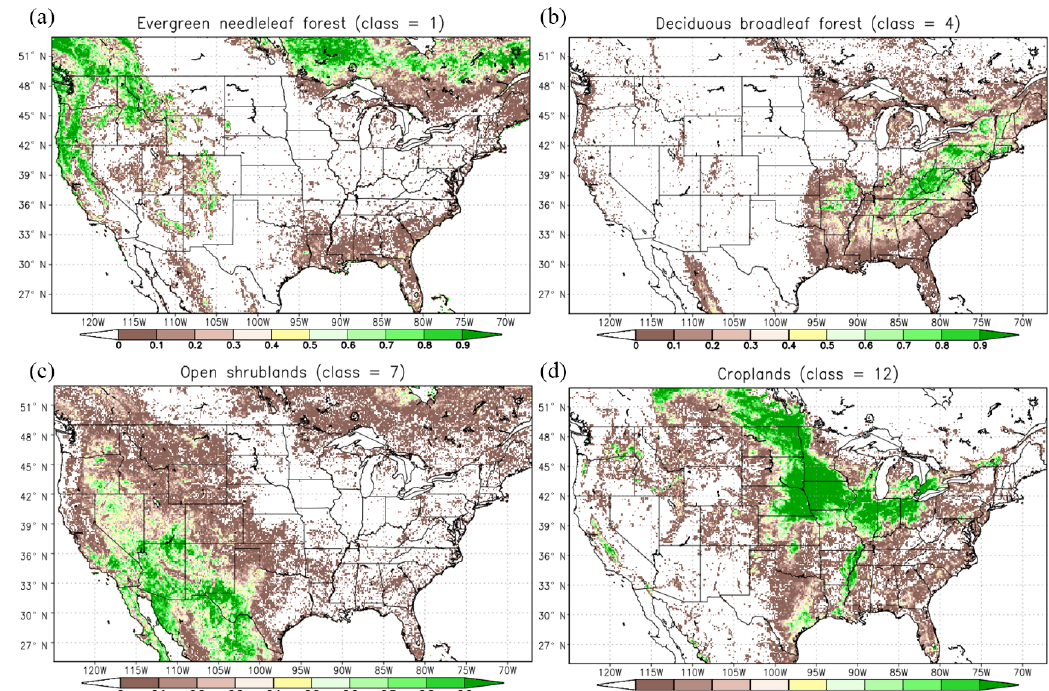
Figure 4. Vegetation distribution fraction of four different MODIS IGBP land cover classes (as produced by LDT): evergreen needleleaf (a) , deciduous broadleaf forest (b) , open shrublands (c) , and general cropland (d) . Values greater than 0.9 indicate where more than 90% of given grid cell (0.125 ◦ grid cell resolution, in this example) is dominated by that vegetation type.